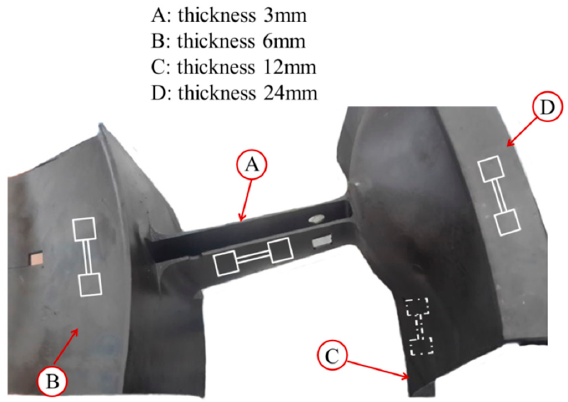
Figure 2. The sampled positions at the superalloy casting.